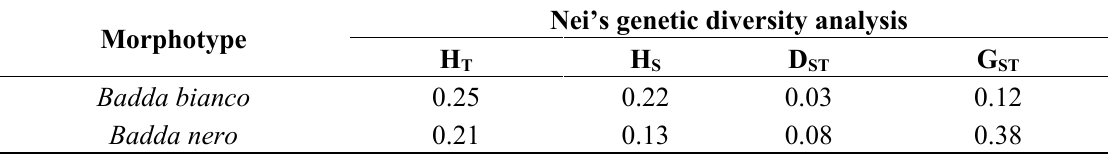
Table 3. Genetic diversity statistics of “Badda” bean